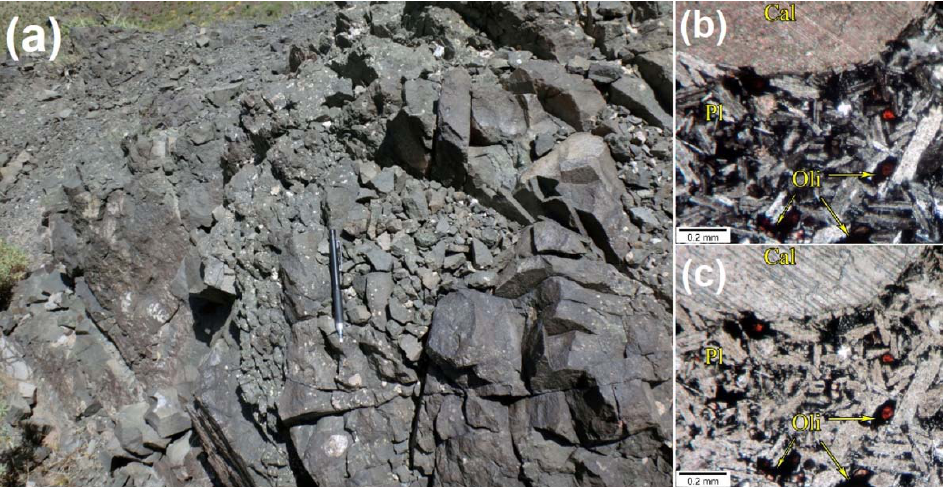
Figure 5. ( a ) Outcrop of basalt, ( b , c ) thin section shows olivine and plagioclase minerals inside secondary calcite in XPL and PPL modes, respectively. Cal: calcite, Oli: olivine, and Pl: plagioclase. Basaltic andesite shows a porphyritic texture with a very fine to glassy groundmass. They are burnt brown to purple in weathered surface and the color of the freshly broken surface is gray to dark gray (Figure 6a). The main minerals are pyroxene, olivine, and plagioclase (Figure 6b,c). Rocks are intensively fractured. Fractures may be filled with veins containing calcite, epidote, quartz, or iron oxide. Weak Cu mineralization is seen in some epidote veins but probably has no economic importance (Figure 6a).